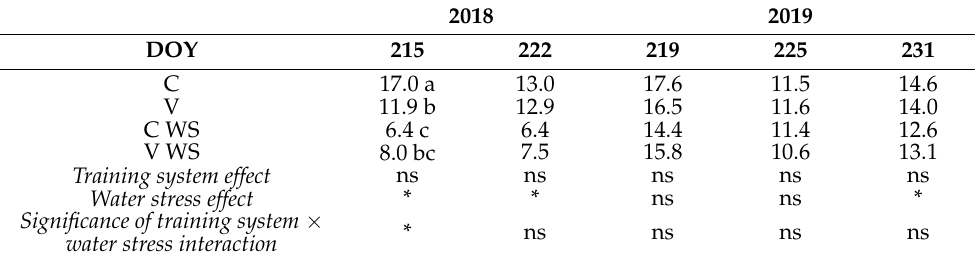
Table 3. The leaf assimilation rate (An, µ mol m − 2 s − 1 ) during the 2018 and 2019 season. Values represent means of 4 replicates: C WW= well-watered vertical shoot-positioned canopy, V WW = well-watered V-shaped open canopy, C WS = vertical shoot-positioned canopy with water restriction, V WS = V-shaped open canopy with water restriction. Significant differences are indicated: *, p < 0.05; ns, not significant. Mean values were separated within each column with different letters using the Tukey test.